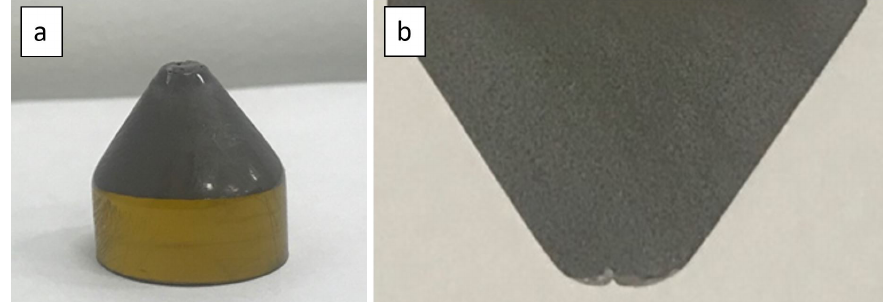
Figure 2. Green body fabricated under centrifugal force of 3700 G , ( a ) sample extracted from the die, and ( b ) cross-sectional view of the specimen.